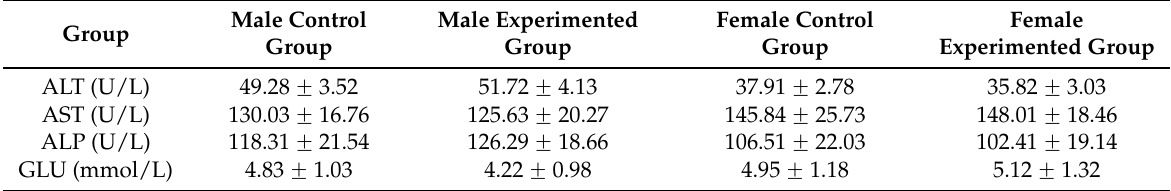
Table 3. Serum biochemical parameters of mice in the acute toxicity